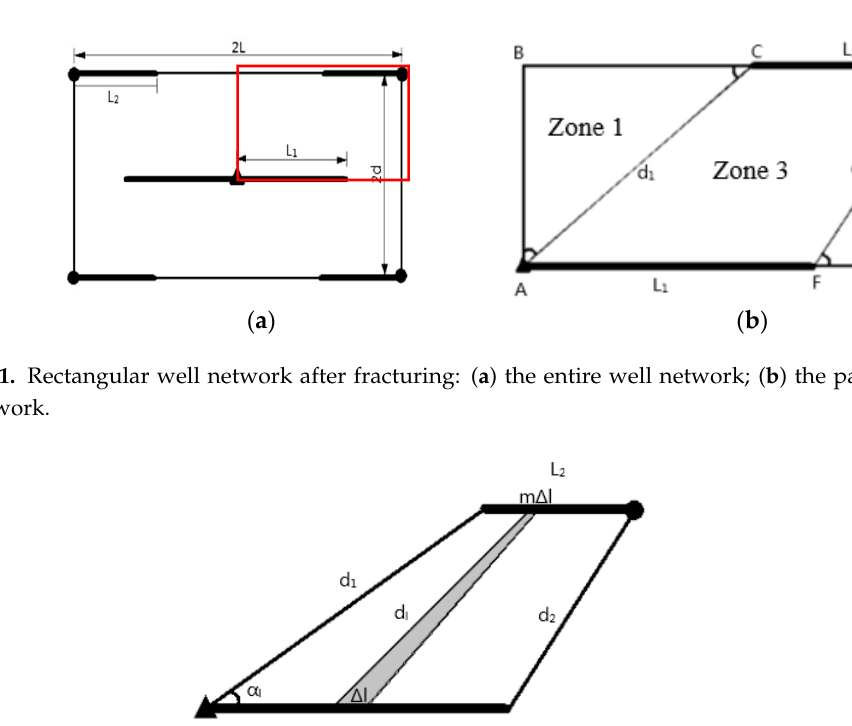
Figure 12. Schematic diagram of the Zone 3 computation unit.